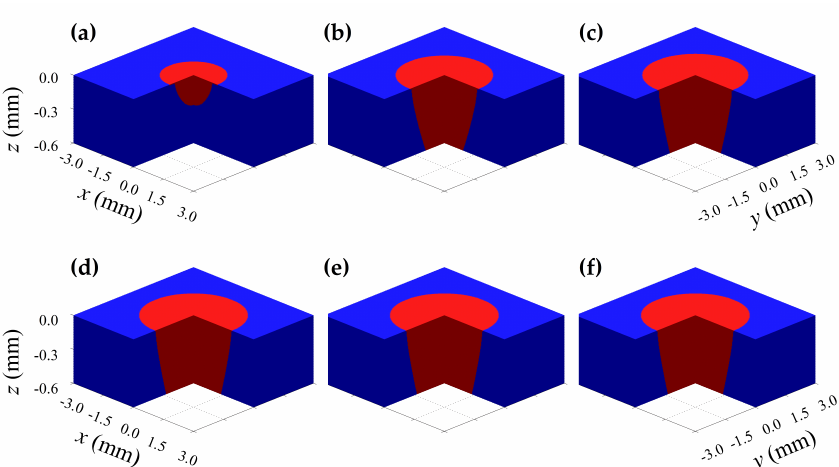
Figure 5. Time-dependent evolution of collagen-shrinkage tomography under terahertz heating with beam radius w 0 = 3mm, power density P d = 0.6W/cm 2 , and exposure time of ( a ) 10 s; ( b ) 30 s; ( c ) 60 s; ( d ) 180 s; ( e ) 300 s; and ( f ) 1200 s. Blue regions indicate nonshrinkage regions, and red regions the shrinkage regions. Shrinkage threshold value was taken to be 55 ◦ C.